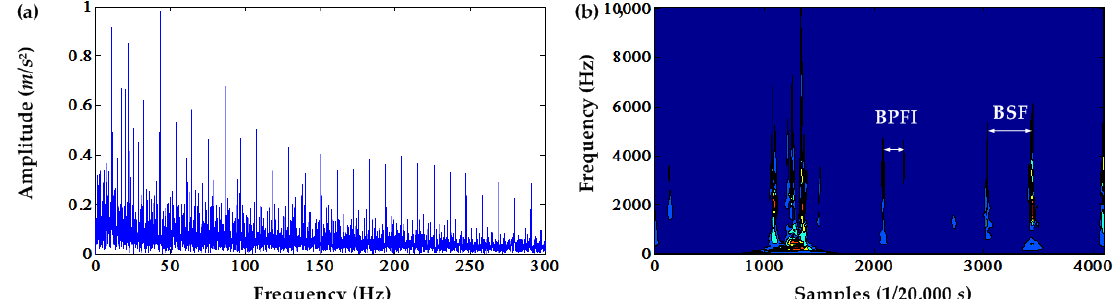
Figure 17. ( a ) Squared envelope spectrum after the sixth DC offset cancellation; ( b ) time-frequency contour of the squared envelope signal after the sixth DC offset cancellation.